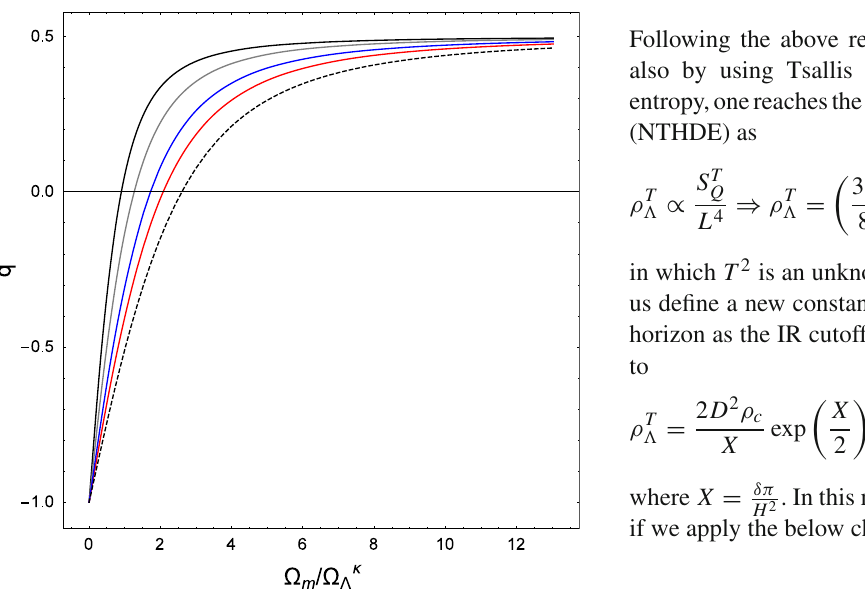
= 67 . 9. We have 0 /(cid:8) κ ≈ 2 . 01 at m (cid:7)